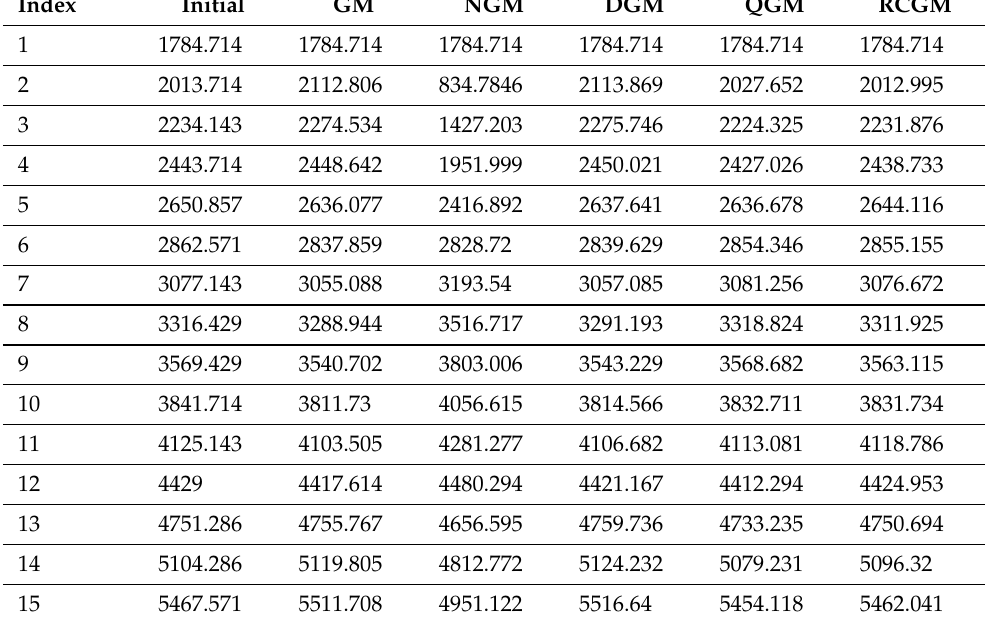
Table 7. Predicted values from Gujarat data Model